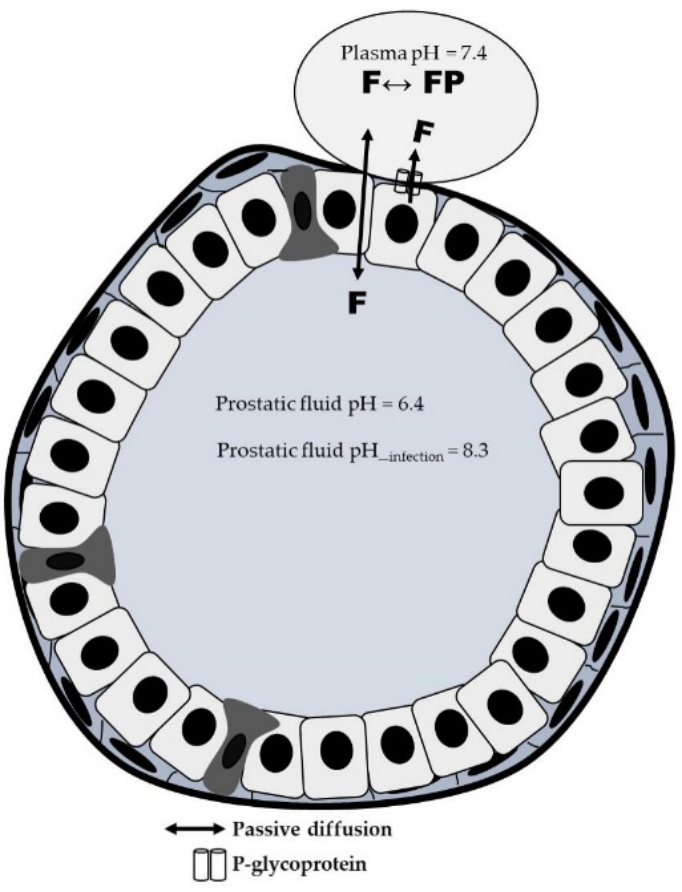
Figure 2. Distribution mechanisms of fluoroquinolone from the blood to the prostate gland. F: unbound fluoroquinolone; FP: protein-bound fluoroquinolone.